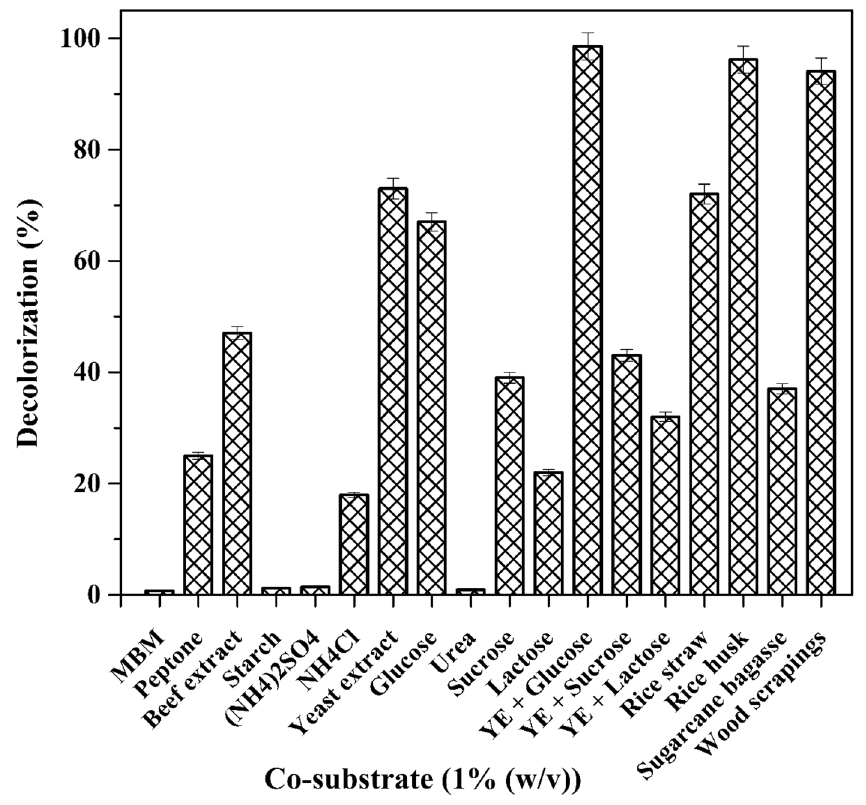
Figure 1. Effect of supplementation of different co-substrate on the Indanthrene Blue RS decolorization by